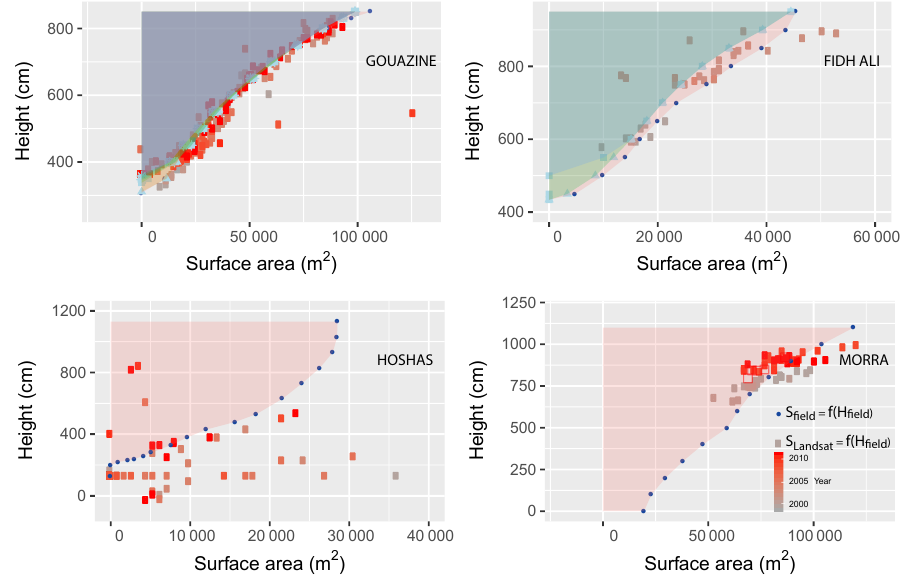
Figure 16. Comparison of field-based H – S rating curves and the H – S rating curves that could be established based on Landsat surface water observations over 1999–2014.